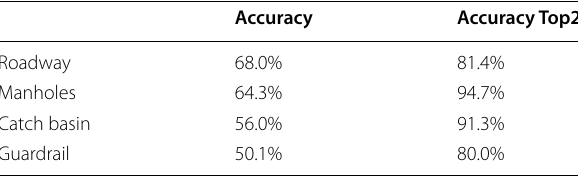
Table 4 Performance of chosen models of 4 facility